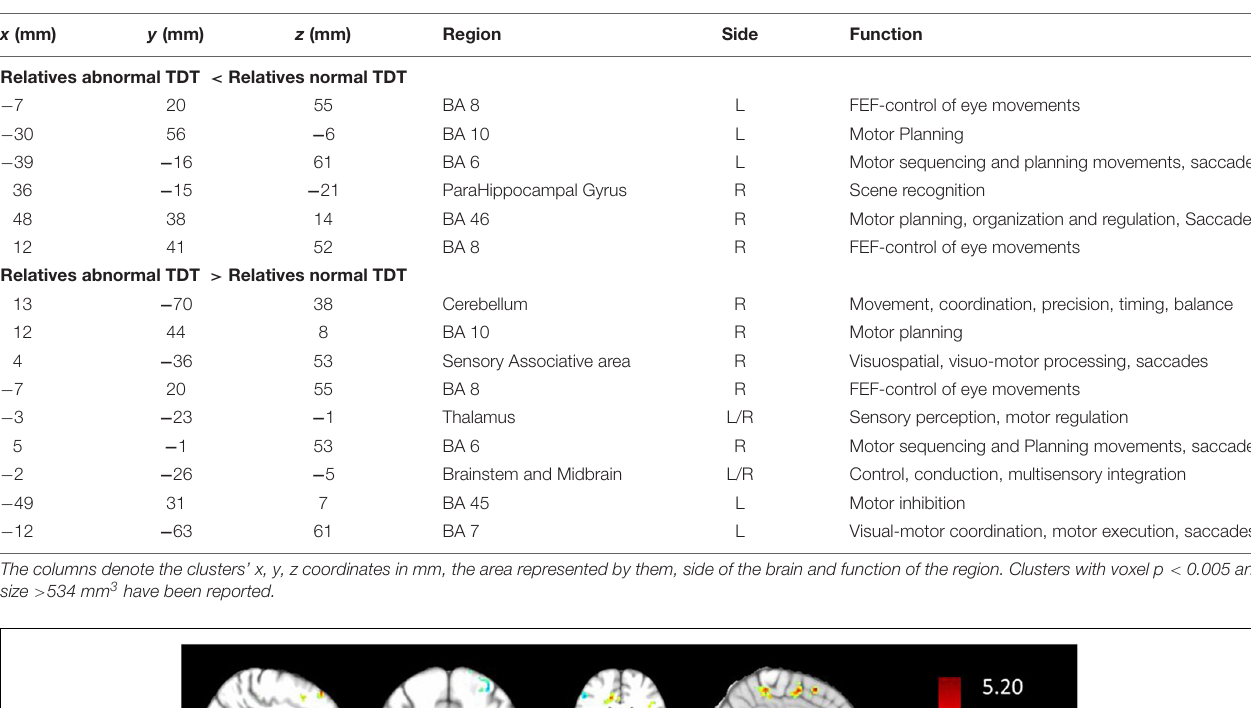
TABLE 2 | Significant differences in regional homogeneity (ReHo) (corrected p < 0.05) between relatives with normal and abnormal TDT.